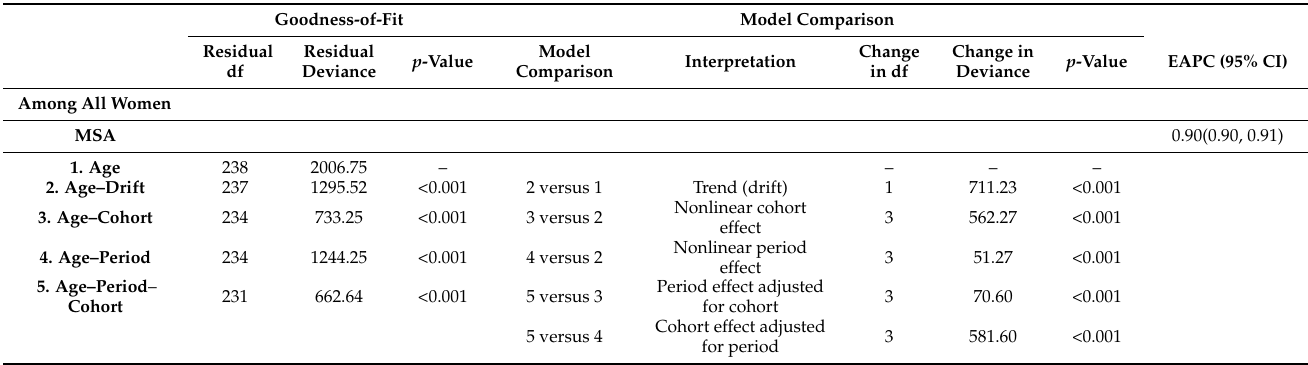
Figure 3. Age-group-specific CIN2+ incidence per 100,000 person-years by period and birth cohort among the subset of women enrolled in Tennessee Medicaid who were screened for cervical cancer. CIN2+: cervical intraepithelial neoplasia grades 2 and 3 and adenocarcinoma in situ; MSA: metropolitan statistical area. Table 4. Age–period–cohort models for CIN2+ incidence among all women enrolled in Tennessee Medicaid and the subset of women screened for cervical cancer, by urbanicity,